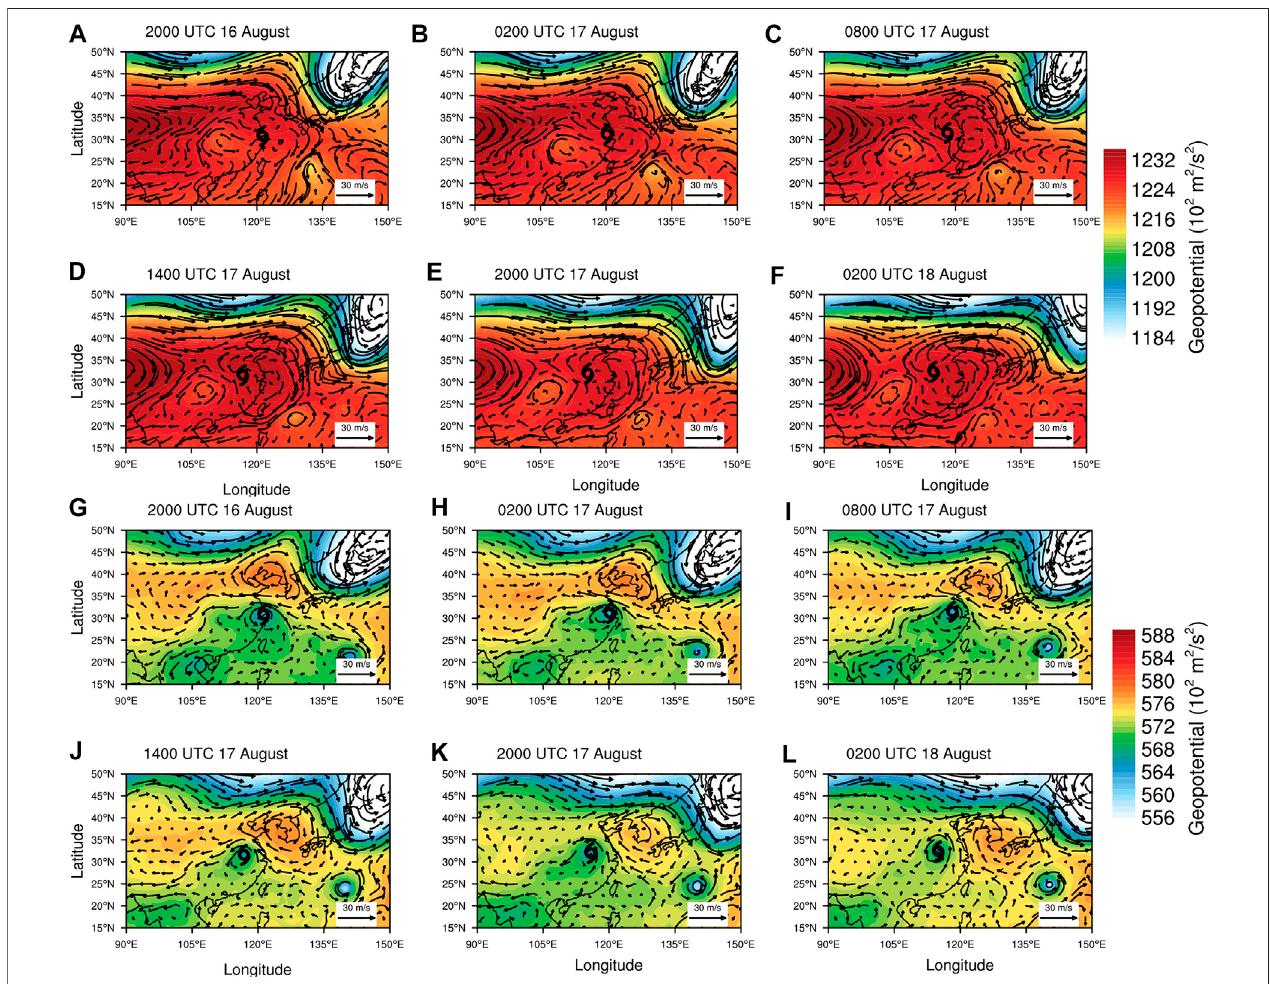
FIGURE 3 | Geopotential height (shading, 10 geopotential meters) and wind vectors (m s − 1 ) at 200 hPa: (A) 2000 UTC 16 August, (B) 0200, (C) 0800, (D) 1,400, (E) 2000 UTC 17 August, (F) 0200 UTC August 18, 2018, and at 500 hPa: (G) 2000 UTC 16 August, (H) 0200, (I) 0800, (J) 1,400, (K) 2000 UTC 17 August, (L) 0200 UTC August 18,